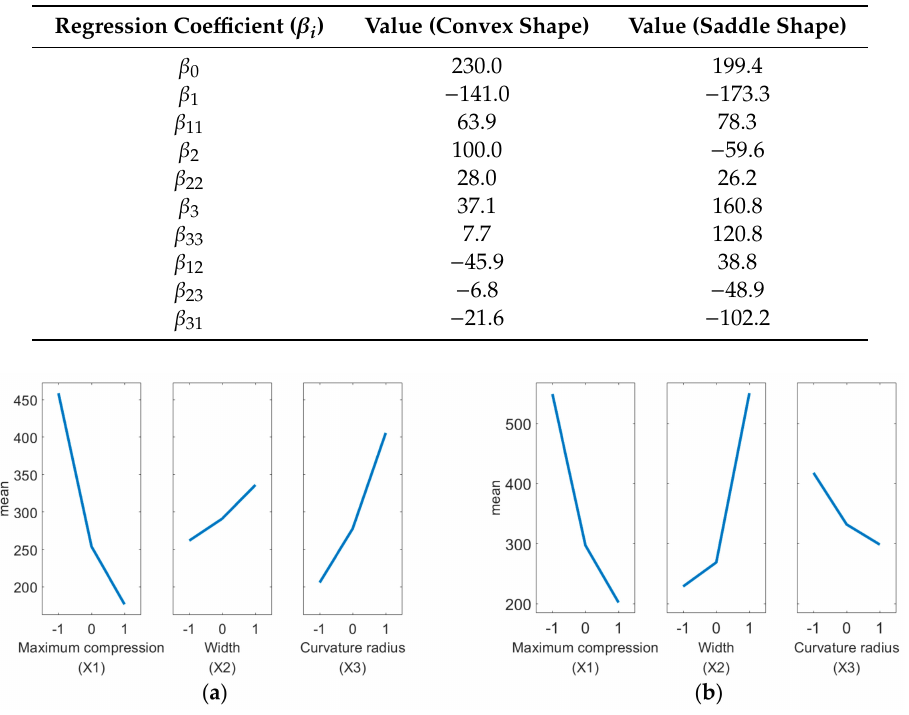
Table 5. Estimated regression coe ffi cients.